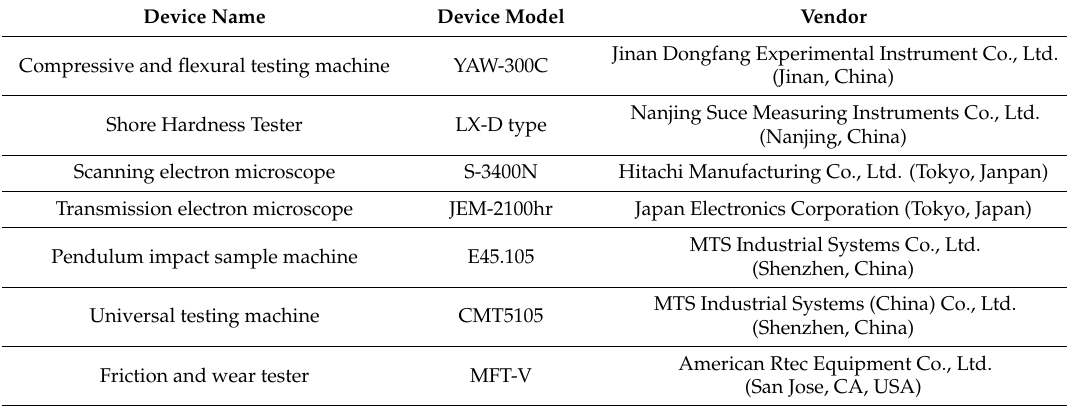
Table 2. Main test and analysis instruments used in the